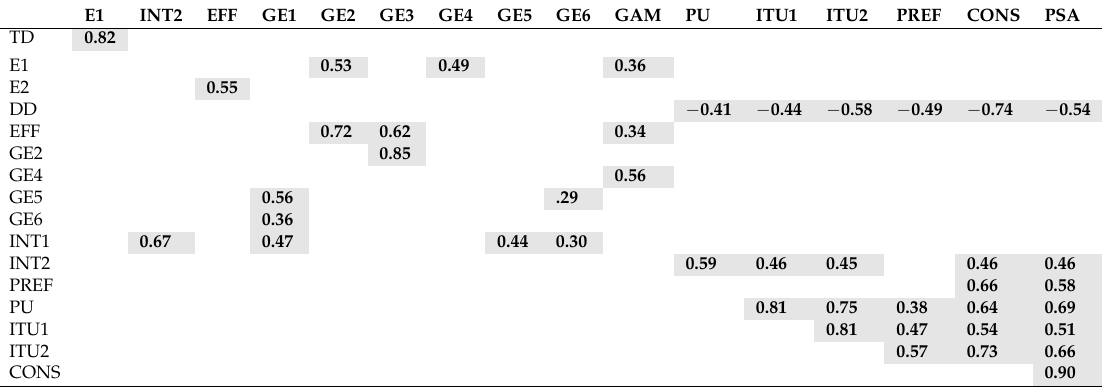
Table 2. Spearman’s rank correlation coefficient. Significant values ( p -value < 0.05) are marked in